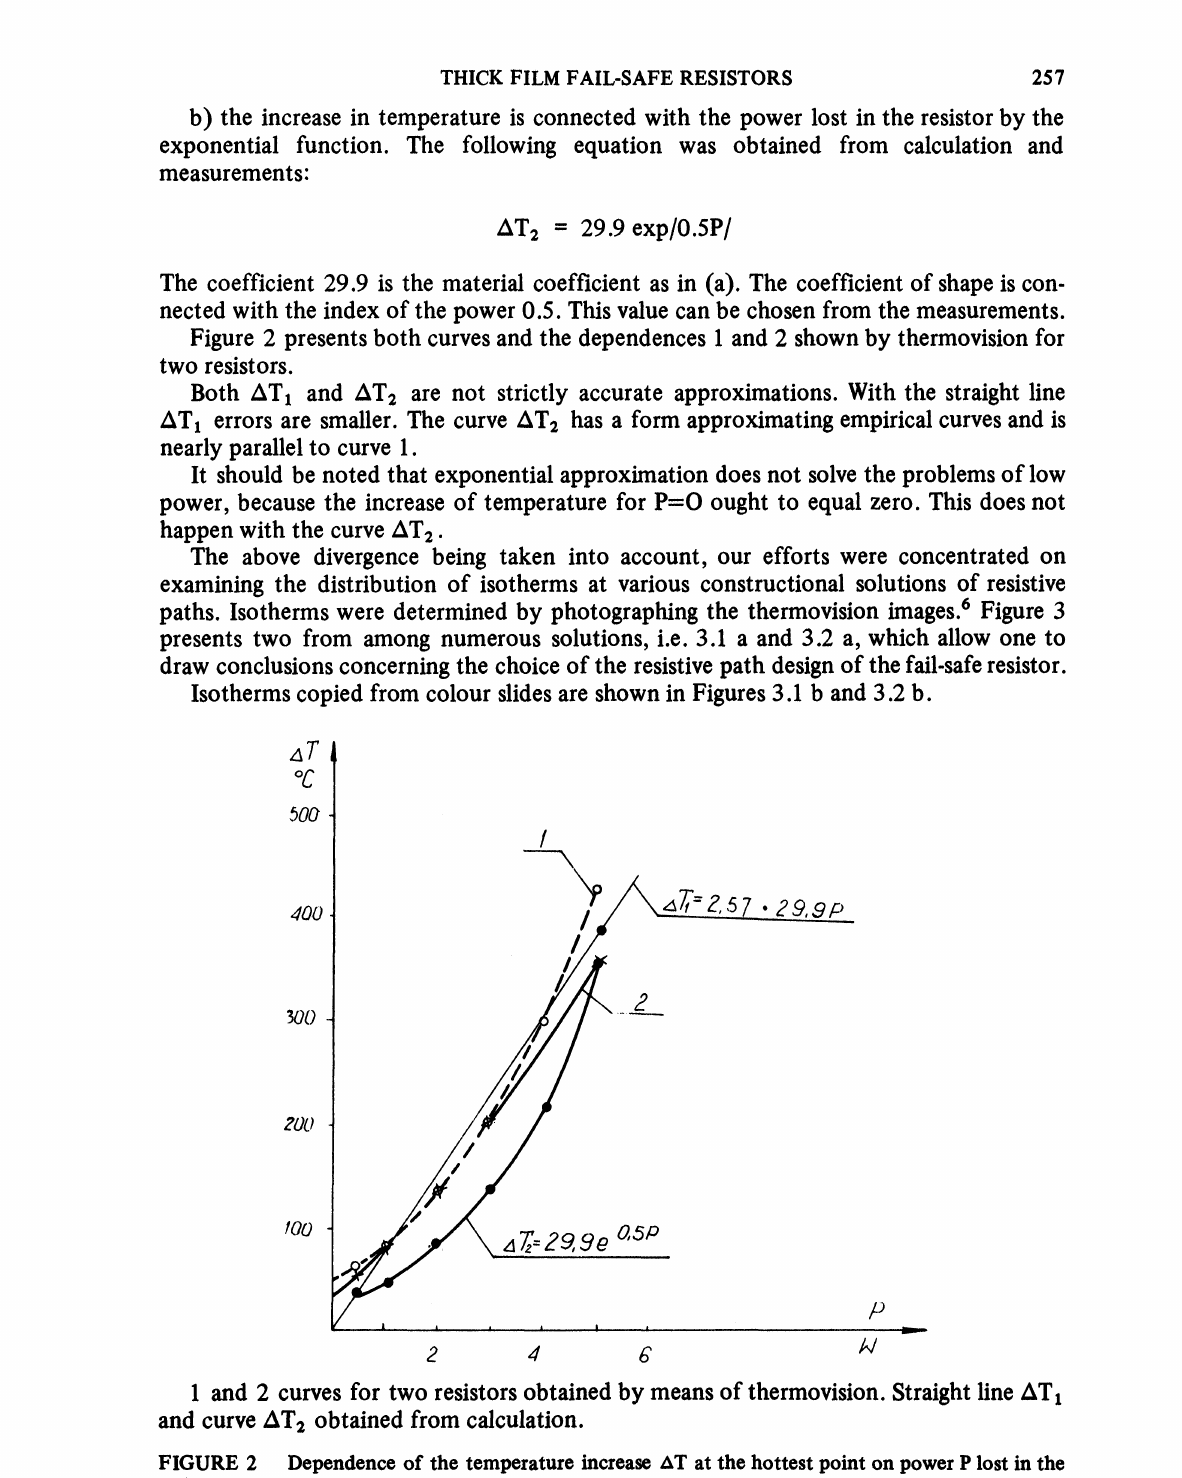
FIGURE 2 Dependence of the temperature increase AT at the hottest point on power P lost in the